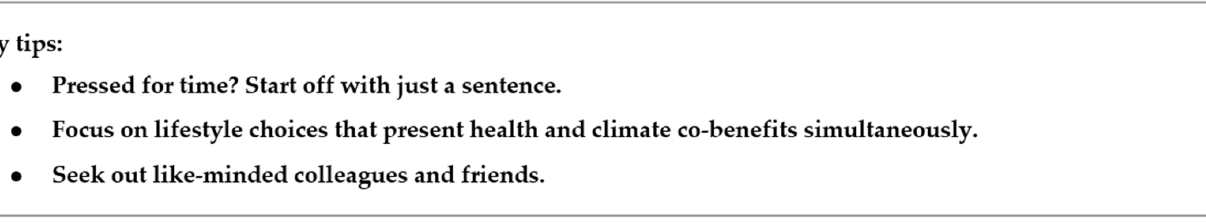
Figure 1. Key tips for clinicians to implement planetary health into their professional practice.